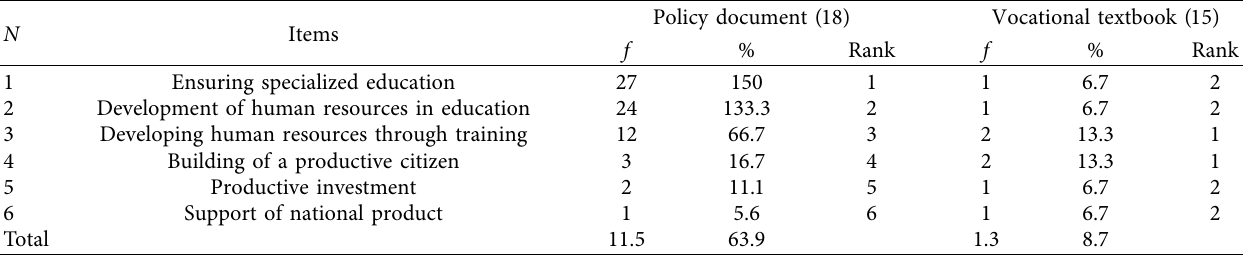
Table 5: The descending order of the economic values related to production contained in the provisions of the Saudi Arabian vocational textbook (15 lessons) and the Educational Policy Document (18 parts). N